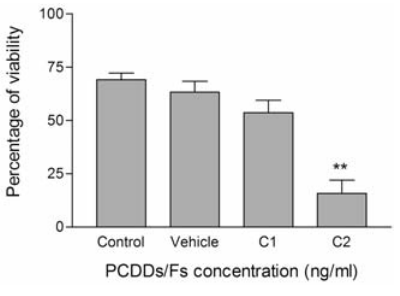
Figure 2. Viability of cœlomocytes follow- ing 3 h of preincubation with polychlori- nated dibenzo -p- dioxins/dibenzofurans (PCDDs/Fs) and 18 h with beads. Data are presented as mean ± SD (n=6), asterisks indicate significant difference (P<0.01) from vehicle.